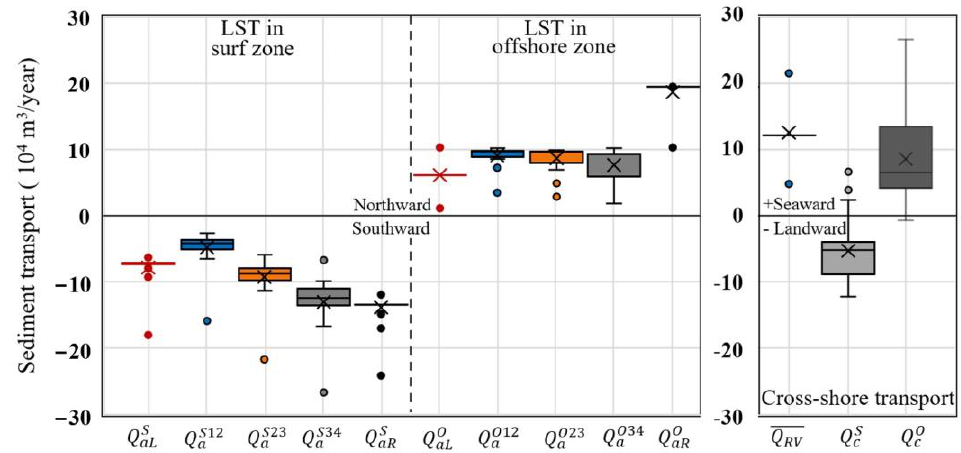
Figure 12. Net sediment transport rates along the longshore in the surf zone, offshore zone, and the cross-shore sediment transport rate; (LTS: longshore sediment transport). Within each box, horizontal black x-mark denote mean values; the outliers are shown as a dot for each parameter.